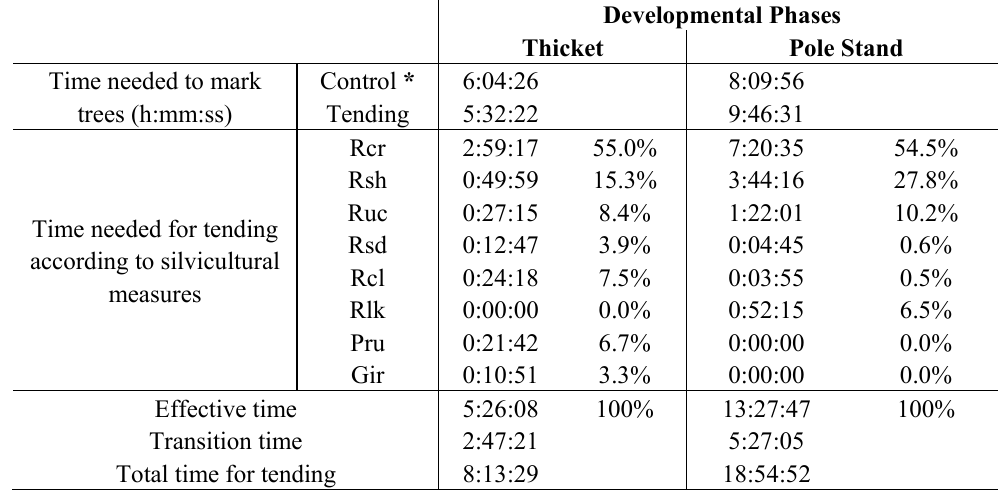
Table 2. The average time consumption per ha for the tending of young forest by developmental phase and silvicultural measure on Tending